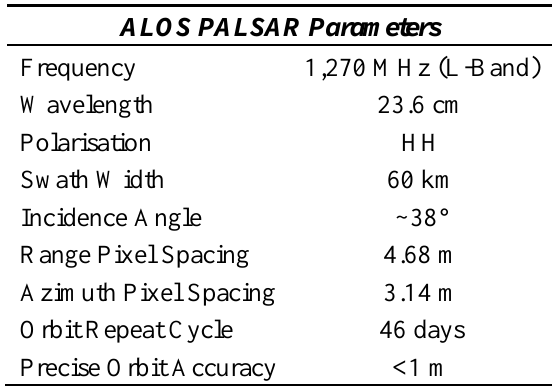
Table 1. Basic characteristics for ALOS PALSAR data in FBS mode used in this study.